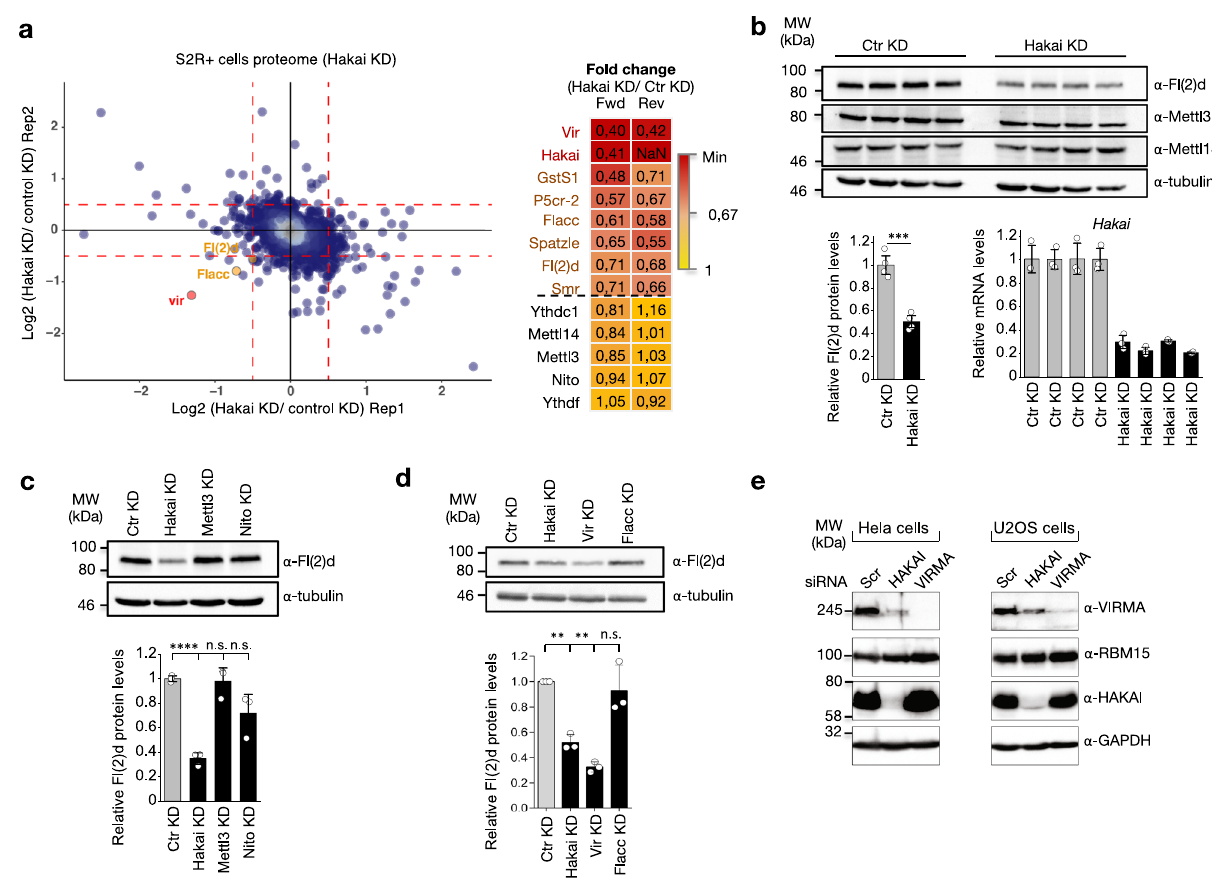
Fig. 6 Hakai regulates the stability of other MACOM components. a Mass spectrometry analysis of Hakai-dependent proteome in S2R + cells. Scatter plot of normalized forward versus inverted reverse experiments plotted on a log2 scale. The threshold was set to a 1.4-fold enrichment or depletion (red dashed line). Proteins in the bottom left quadrant are decreased in both replicates. Heat map of proteins whose levels were reduced by >1.4-fold in both replicates of the whole proteome analysis. Other components of the m 6 A writer complex and reader proteins are shown for comparison. A complete list of quanti fi ed proteins can be found in Supplementary Data 4. b Levels of endogenous Fl(2)d, Mettl3 and Mettl14 proteins from control cells and cells depleted for Hakai were analyzed by western blot. Tubulin was used as a loading control. Quanti fi cation of Fl(2)d, Mettl3 and Mettl14 levels from blots shown below (left). The bar chart shows the mean with standard error (SE) of four biological replicates. ∗∗∗ P = 2.48E − 04 (Hakai KD). Unpaired two-tailed Student ’ s t - test for equal variances. Hakai depletion strongly destabilizes Fl(2)d, but not Mettl3 or Mettl14 proteins. Relative expression levels of Hakai are shown as a validation of its KD ef fi ciency. The bar chart shows the mean with standard error (SE) of three technical measurements (Bottom right). c , d Analysis of Fl (2)d levels upon Hakai , Mettl3 , nito ( c ) or Hakai , vir , Flacc ( d ) depletion. Protein lysates from control and depleted cells were analyzed by western blot for levels of endogenous Fl(2)d protein. Tubulin was used as a loading control. One representative experiment is shown and quanti fi cation of three biological replicates is shown below. The bar chart shows the mean with standard error (SE). ( c ) ∗∗∗∗ P = 4.74E − 05 (Hakai KD), n.s. P = 0.80029 (Mettl3 KD) and n.s. P = 0.05398 (Nito KD). ( d ) ∗∗ P = 0.0057 (Hakai KD), P = 0.0012 (Vir KD) (Hakai KD), and n.s. P = 0.6061 (Flacc KD). Unpaired two-tailed Student ’ s t - test for equal variances. e Western blots were carried out with lysates prepared from HeLa and U2OS cells transfected with scrambled siRNA or siRNA against HAKAI or VIRMA. Extracts were immunoblotted using the indicated antibodies. Depletion of HAKAI reduced VIRMA levels while depletion of VIRMA had no impact on HAKAI levels. Images shown are representative of two biological replicates. Source data for western blots, measurement of protein levels and qPCR are provided as a Source Data fi